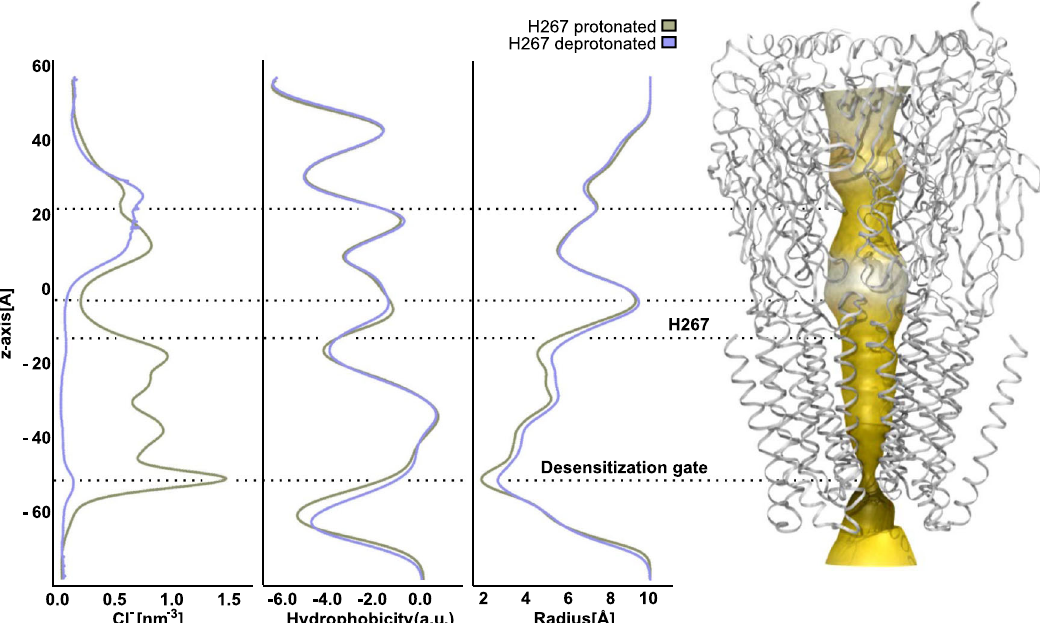
Fig. 5 Protonation of H267 effects pore features as well as Cl - occupancy. Cl − density, hydrophobicity of the pore-facing residues and radius of the pore calculated by the channel annotation programme (CHAP 67 ). Right : Pore of β 3 GABA A R as detected by CHAP. Black dotted lines indicate the projection of the property curves on the pore. Pore properties on the left are the averaged over 2 µ s MD simulation of β 3 GABA A R with H267 protonated and deprotonated β 3 GABA A